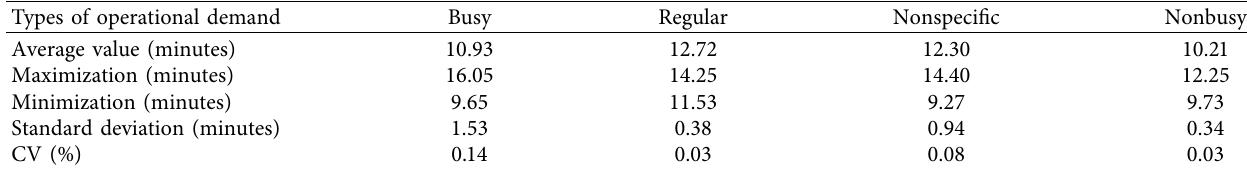
Table 7: Results for solution times for a